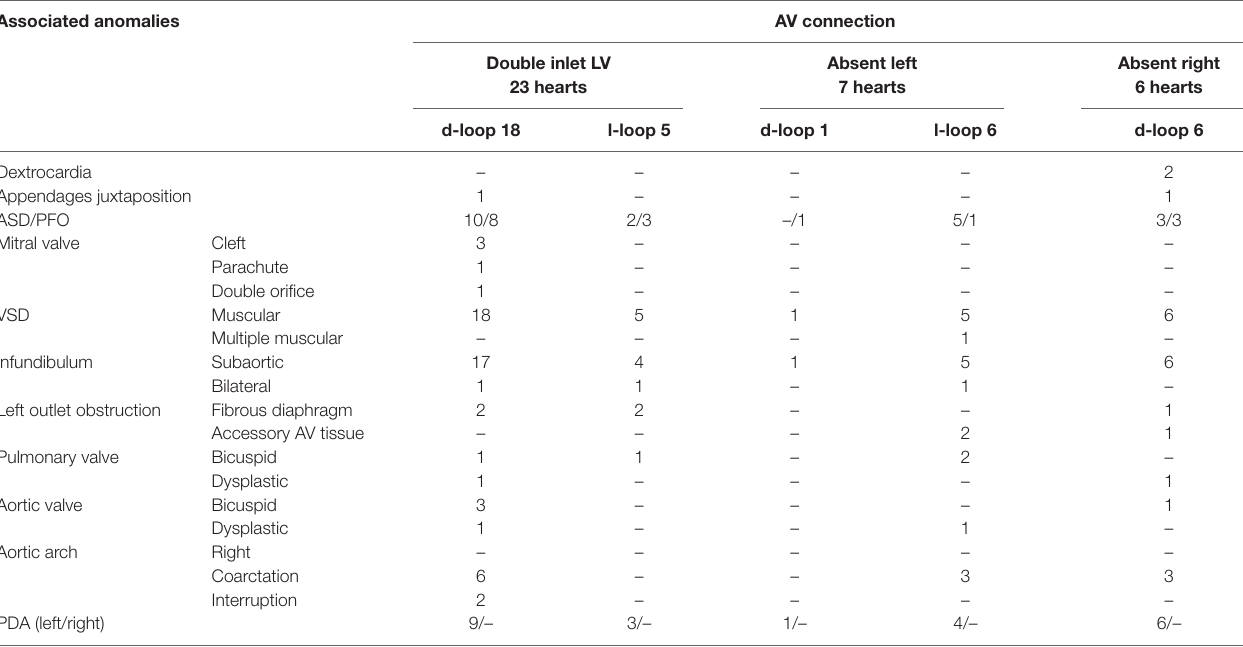
TaBle 12 | Discordant Va connection with univentricular aV connection in situs solitus: associated anomalies. associated anomalies